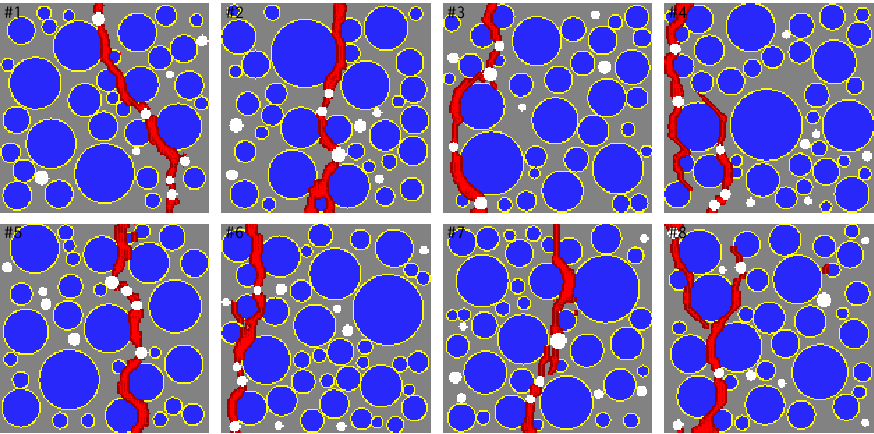
Figure 17. Crack pattern for selected specimens with P pore = 2% and P agg = 40%.